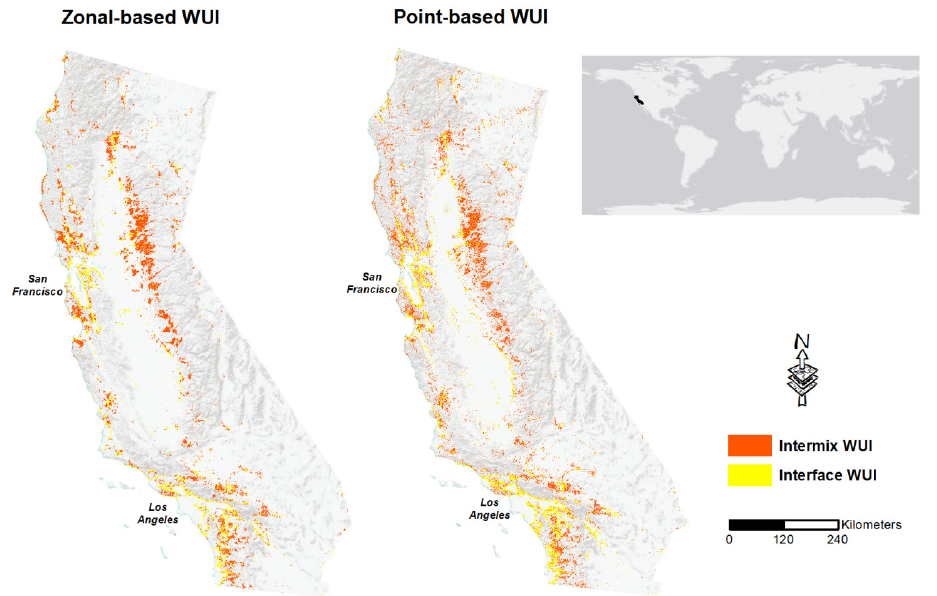
Figure 2. The WUI maps of California used in this study. Left: the zonal-based WUI map of California [7]. Right: a prototype of the point-based WUI of California, based on a 250 m buffer (Carlson et al. in review). Inset: the location of the study region (black) in a world map.